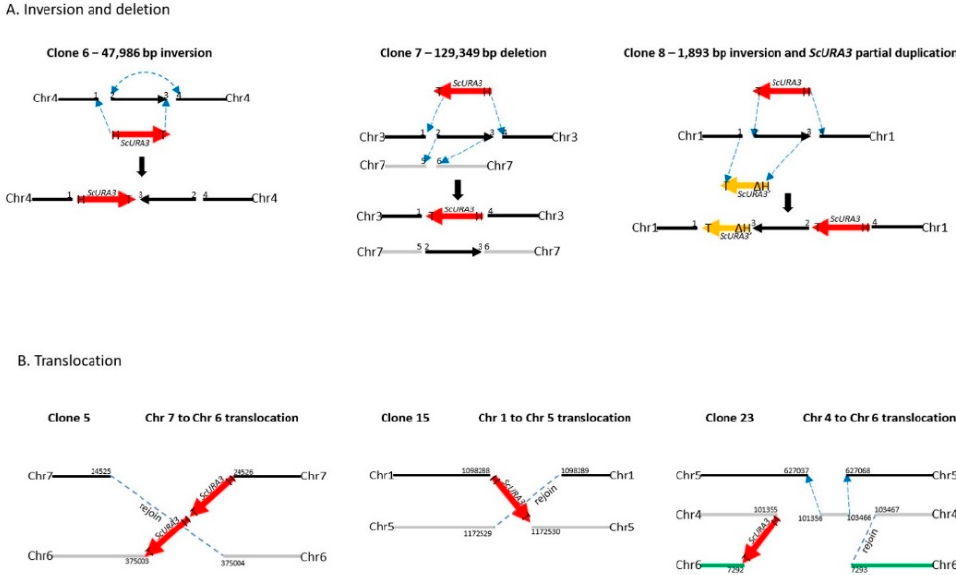
Figure 3. Diagrams of the structures of the ScURA3 insertion events revealed from Illumina MiSeq and Oxford Nanopore sequencing analysis. ( A ). Inversion and deletion events observed in clone 6, 7, and 8. ( B ) Translocation events observed in clone 5, 15, and